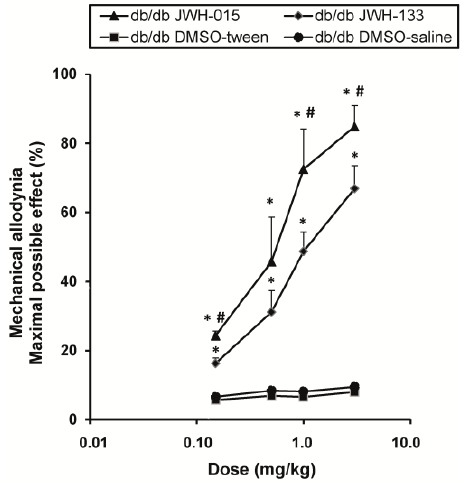
Figure 4. Antiallodynic effects of JWH-015 or JWH-133 in db/db mice. Antiallodynic effects of the subcutaneous administration of different doses (logarithmic axis) of JWH-015 or JWH-133 and their respective controls in the hind paws of db/db mice are represented. Each point represents the mean value of maximal possible effect (%) and vertical bars indicate SEM (6 animals for each dose). For each drug and dose, * indicates significant differences vs. their respective db/db vehicle treated mice and # indicates significant differences vs. effects produced by JWH-133 ( p < 0.05, one-way ANOVA followed by the Student Newman Keuls test).